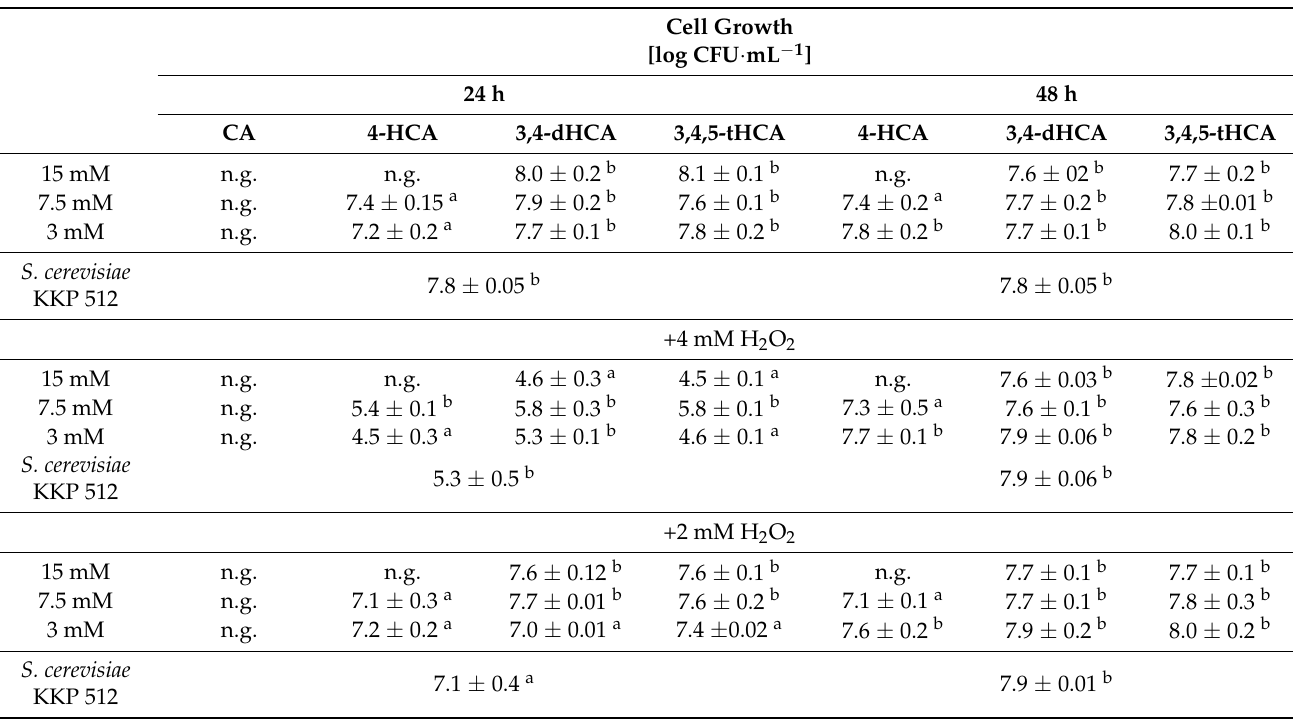
Table 5. Cell growth of the S. cerevisiae KKP 512 in the culture medium at 28 ◦ C after 24 h and 48 h of incubation in the presence of varied concentrations of phenolic acids: CA; 4-HCA; 3,4-dHCA; and 3,4,5-tHCA, with or without of